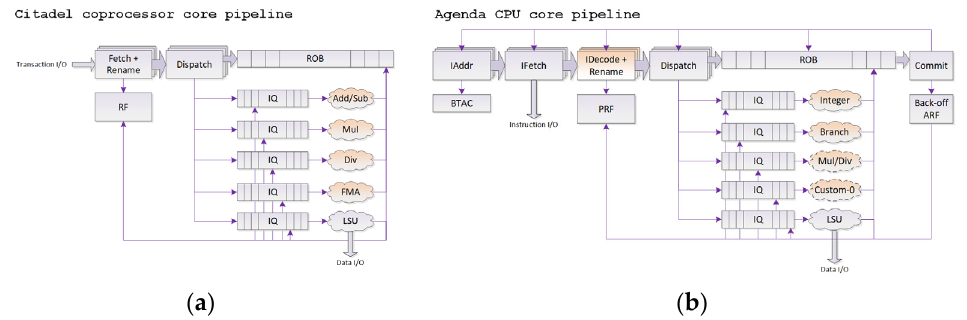
Figure 7. Demo out-of-order designs based on Reordex KIP core: Citadel FPU coprocessor ( a ), Agenda RISC-V CPU core ( b ).